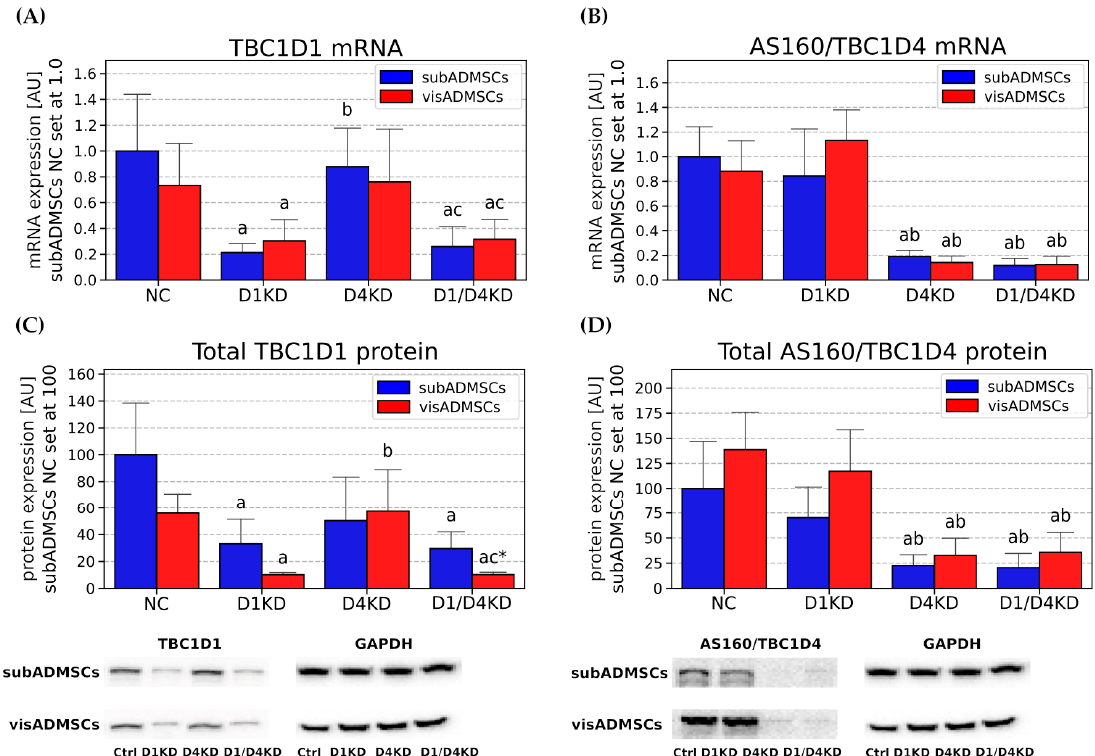
Figure 5. Knockdown efficiency for both Rab-GAPs ( TBC1D1 and TBC1D4 ) at mRNA ( A , B ) and protein level ( C , D ). Bars and whiskers represent the mean and SD, respectively. Number of patients equals four (measurements taken in duplicate). Values are expressed in arbitrary units; the mean in subADMSCs’ negative control was set at 100. Representative Western blots are shown. a—difference versus NC ( p < 0.05); b—difference versus D1KD ( p < 0.05); c—difference versus D4KD ( p < 0.05); * p < 0.05 significantly different from visADMSCs. Designation of the groups: NC—negative control containing non-targeting siRNA fragment; D1KD—knockdown of TBC1D1 ; D4KD—knockdown of TBC1D4 ; D1/D4KD—double knockdown of TBC1D1 and TBC1D4 .